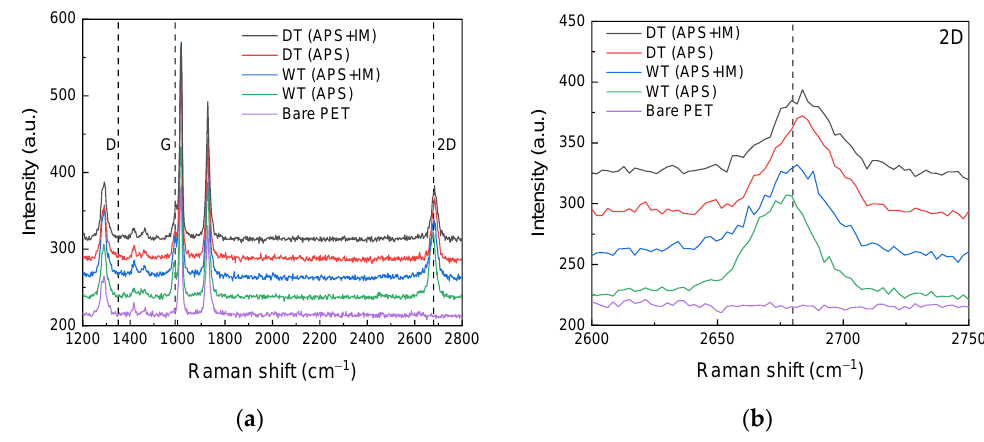
Figure 3. Raman characterization of the microstructural properties of the Gr/PET films and the bare PET substrate. ( a ) Raman spectra and ( b ) enlarged graph comparing Raman 2D bands.